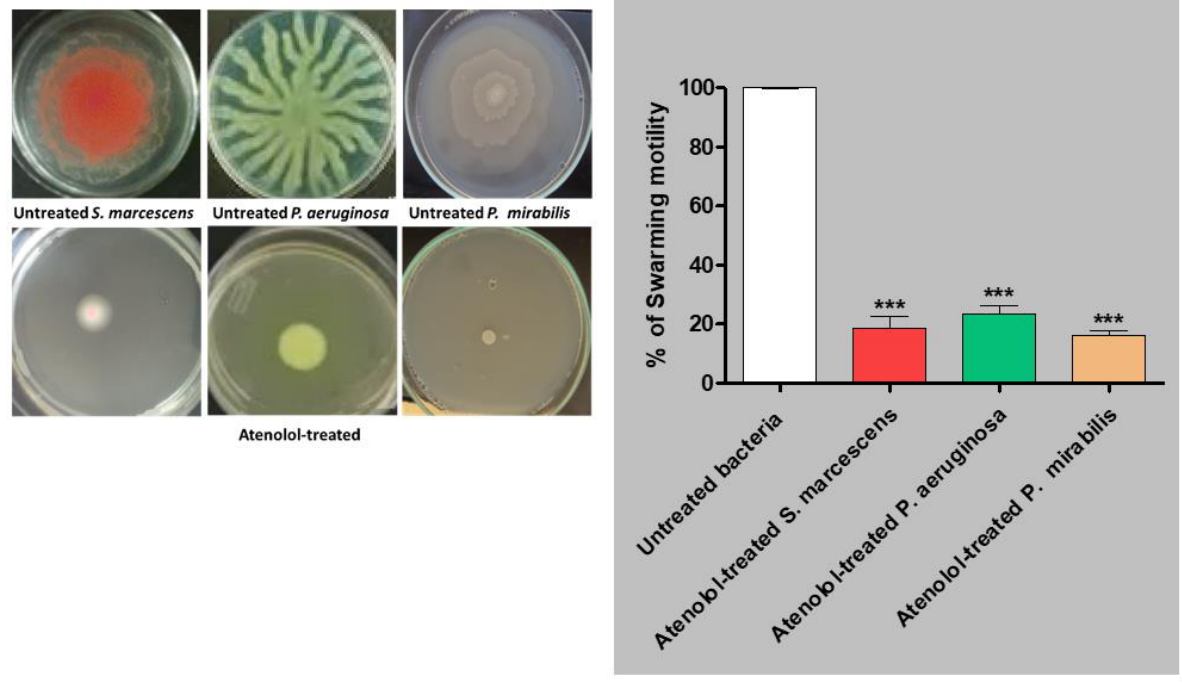
strains were assessed. Atenolol significantly decreased the swarming motility in S. mar- cescens, P. aeruginosa , and P. mirabilis (Figure 10).